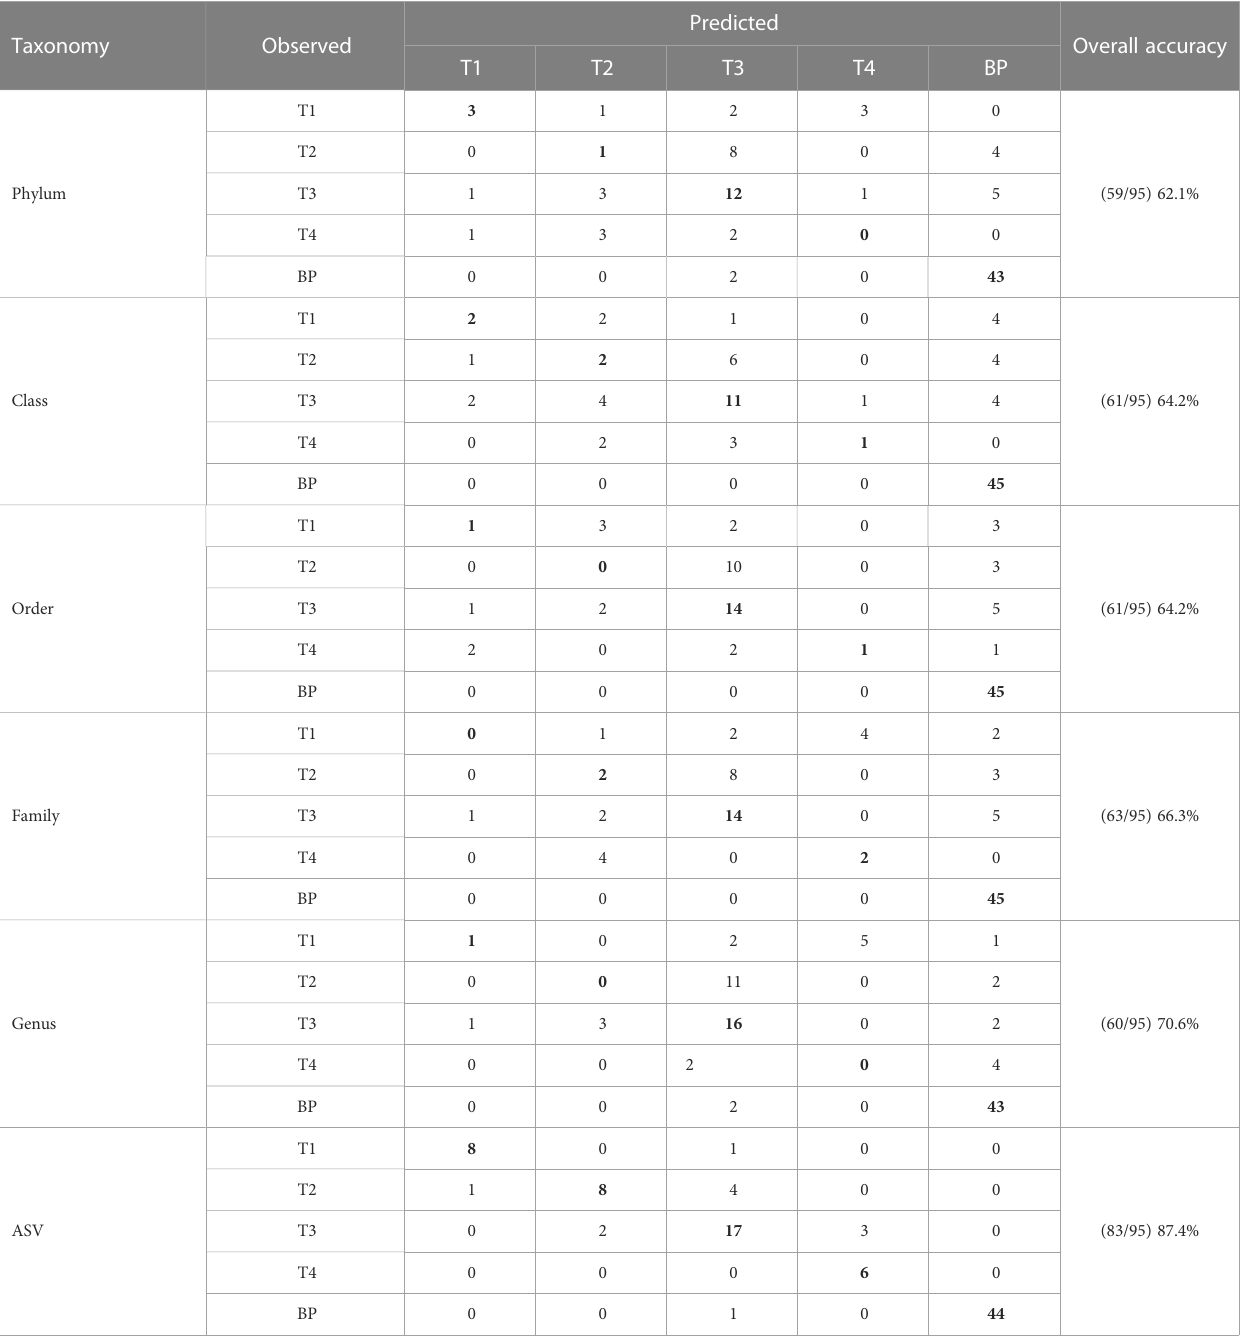
TABLE 1 The predicted accuracy based on pro fi les of colorectal cancer (CRC) stage-discriminatory lineages at bacterial phylum, class, order, family, genus or ASV level, respectively.